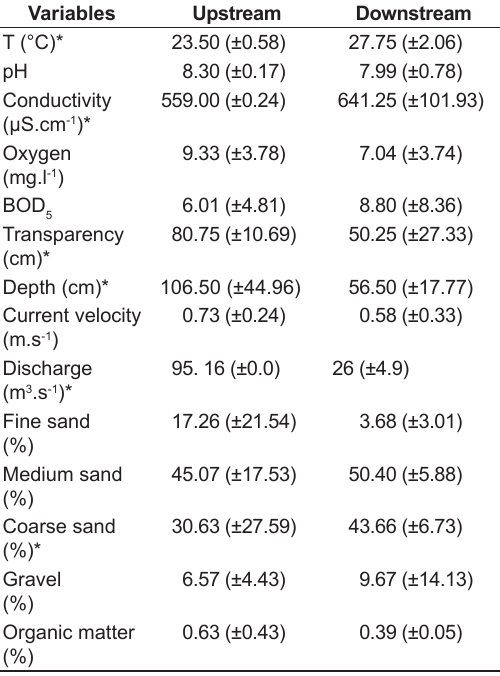
Table 1. Environmental variables analyzed, Mean and Standard